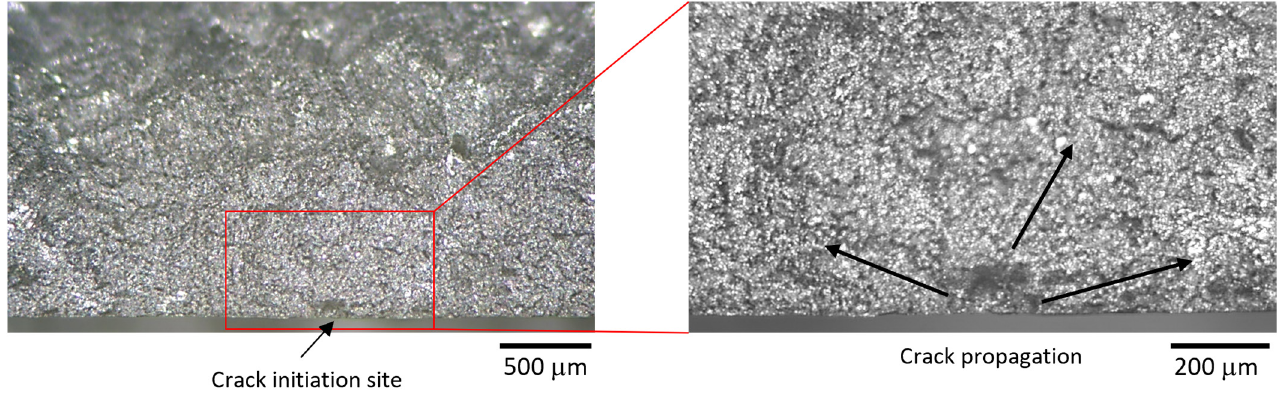
Figure 10. Load–cycle curve of the C-specimens with the Al-F material.